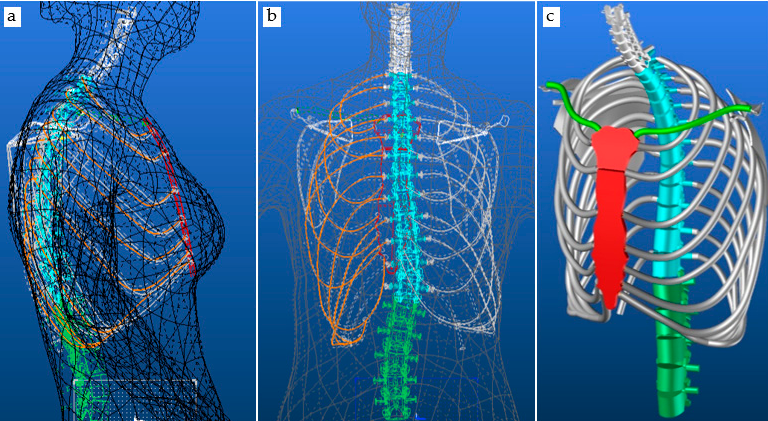
Figure 21. The thorax model parametrized by measured data inside scanned patient body ( a ) the overall volume of the model, ( b ) orientation of the spine in the coronal plane and ( c ) 3D thorax model for the patient.